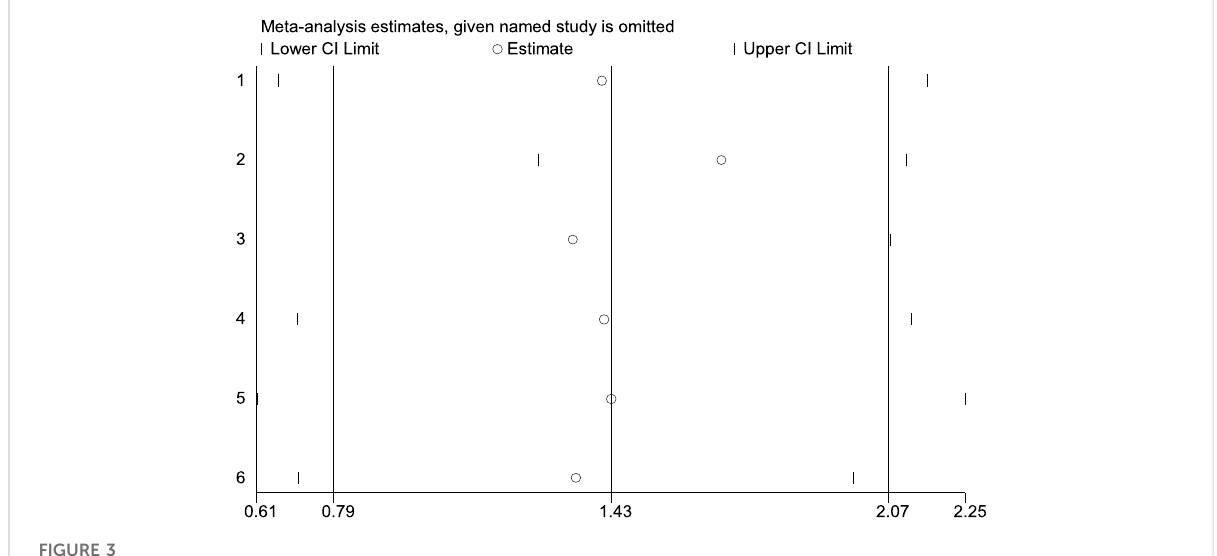
FIGURE 3 Sensitivity analysis of the association between irregular diet and risk of esophageal cancer.